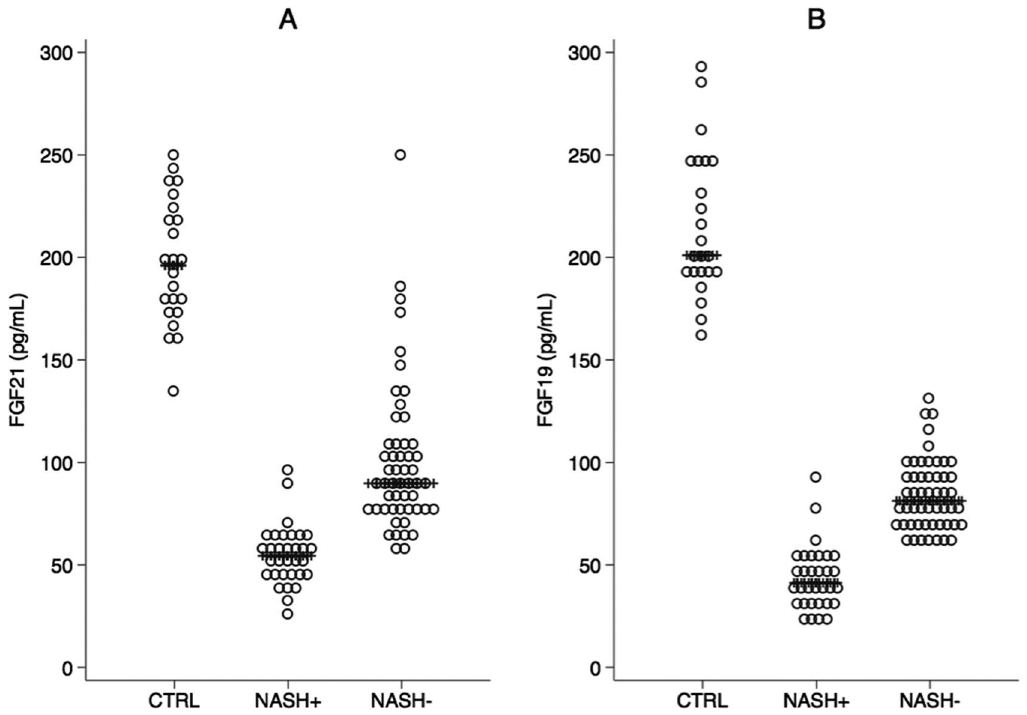
Figure 1. NASH and serum levels of FGF21 and FGF19. Distribution of serum FGF21 (panel A ) and FGF19 (panel B ) in controls, NAFLD children without NASH (NASH 2 ) and NASH children with NASH (NASH + ). Lines superimposed to dot-plots are medians.